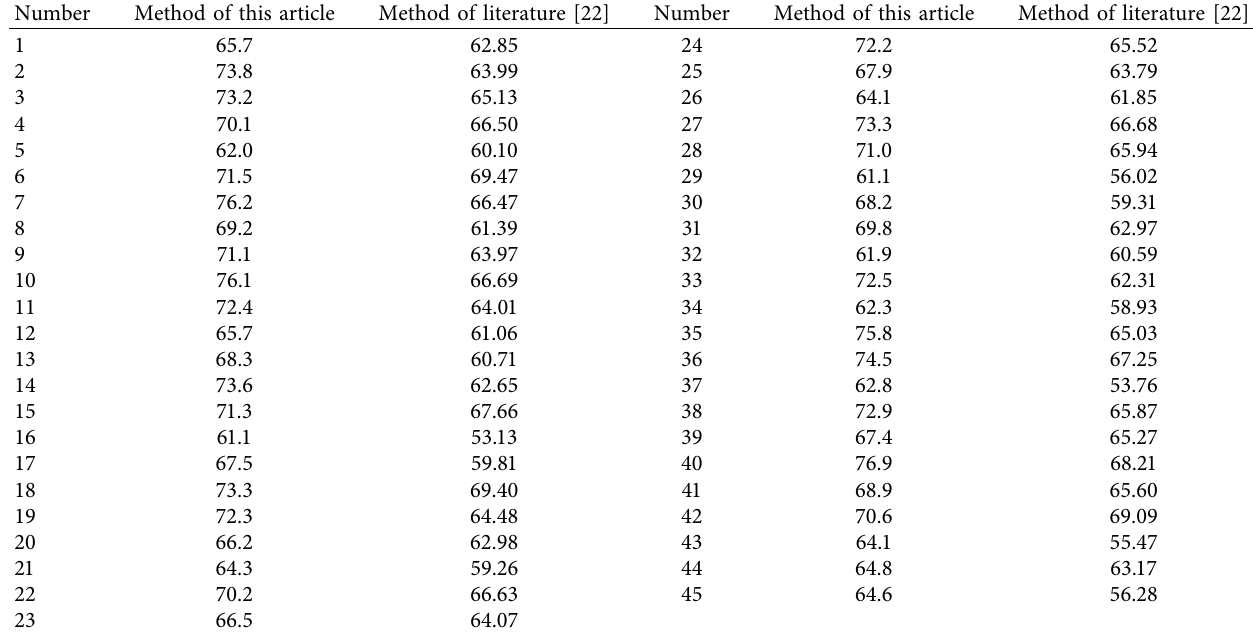
Table 4: Evaluation of the improving effect of English